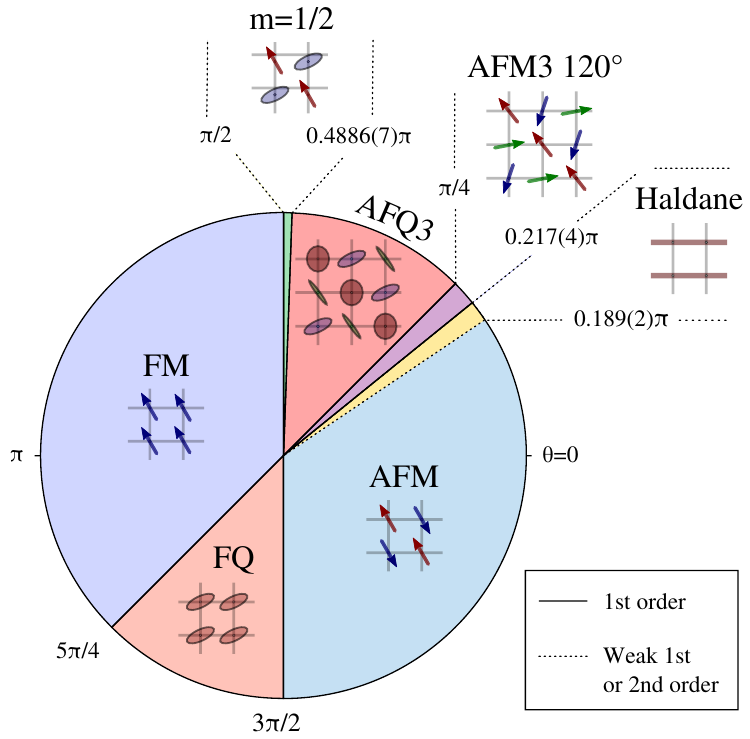
Figure 8: The phase diagram according to our iPEPS data. All phase transitions are of first order (solid lines), except possibly the AFM to Haldane phase transition, which is a weak first or second order phase transition (dotted